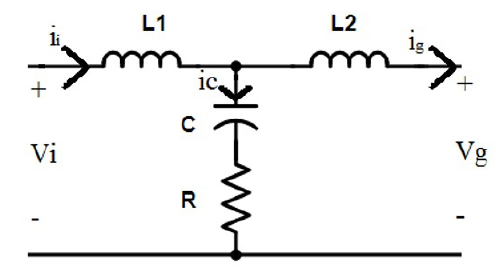
Figure 7. LCL filter per-phase